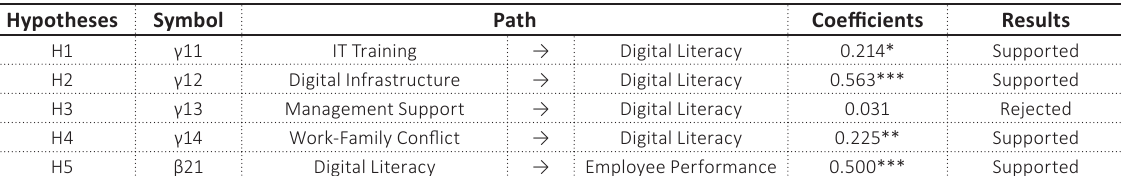
Table 4. Proposed model